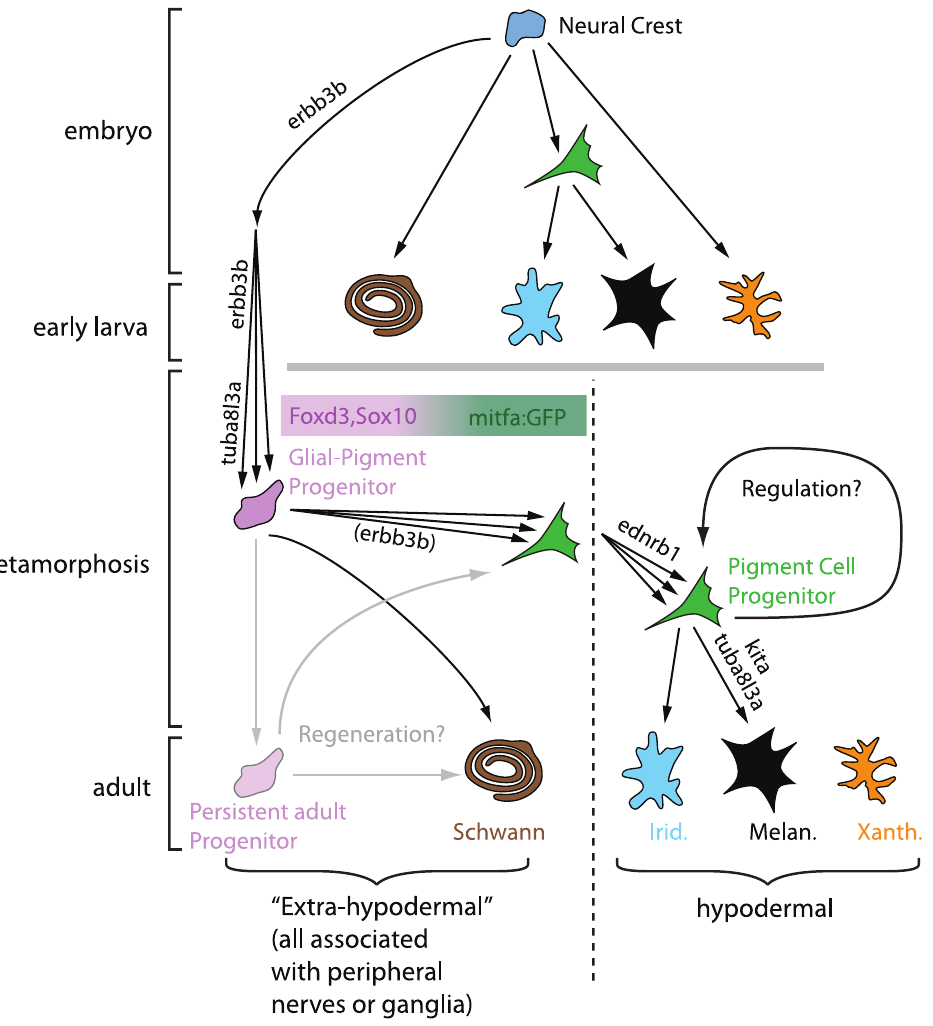
Figure 1. Model for neural origins of metamorphic melanocytes and iridophores. All pigment cells are highly likely to originate from embryonic neural crest, but pigment cells in the embryo and early larva have lineages distinct from pigment cells in the adult. The latter arise from a Glial-Pigment Progenitor population (described as mGP in Budi et al. [3]) that can be recognized in the larval-to-adult transition and exist outside the ‘‘skin’’ in an extra-hypodermal location, identified as within the peripheral nervous system. Once in the ‘‘skin’’ (the hypodermis), the Pigment Cell Progenitor population can further expand and/or differentiate into iridophores (Irid.) and into melanocytes (Melan.). Adult xanthophores (Xanth.) are derived from a different lineage. The regenerative capacity for pigment cells and glia is likely to be explained by the persistence of Glial-Pigment Progenitor cells into adulthood. Modified from Budi et al. [3].